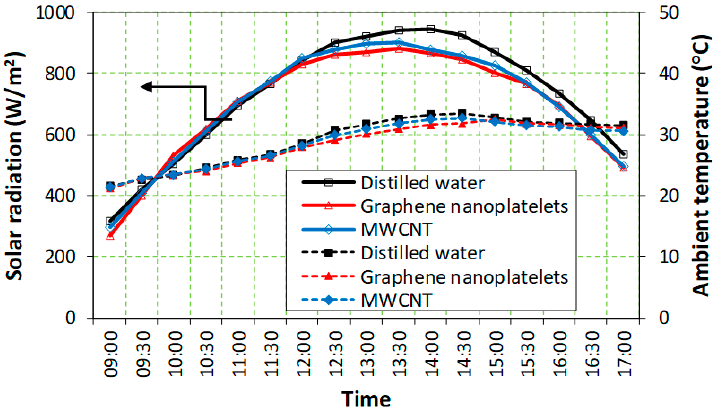
Figure 5. Changes in solar radiation and ambient temperature in the experiments selected with the same conditions at a flow rate of 0.5 L/min.